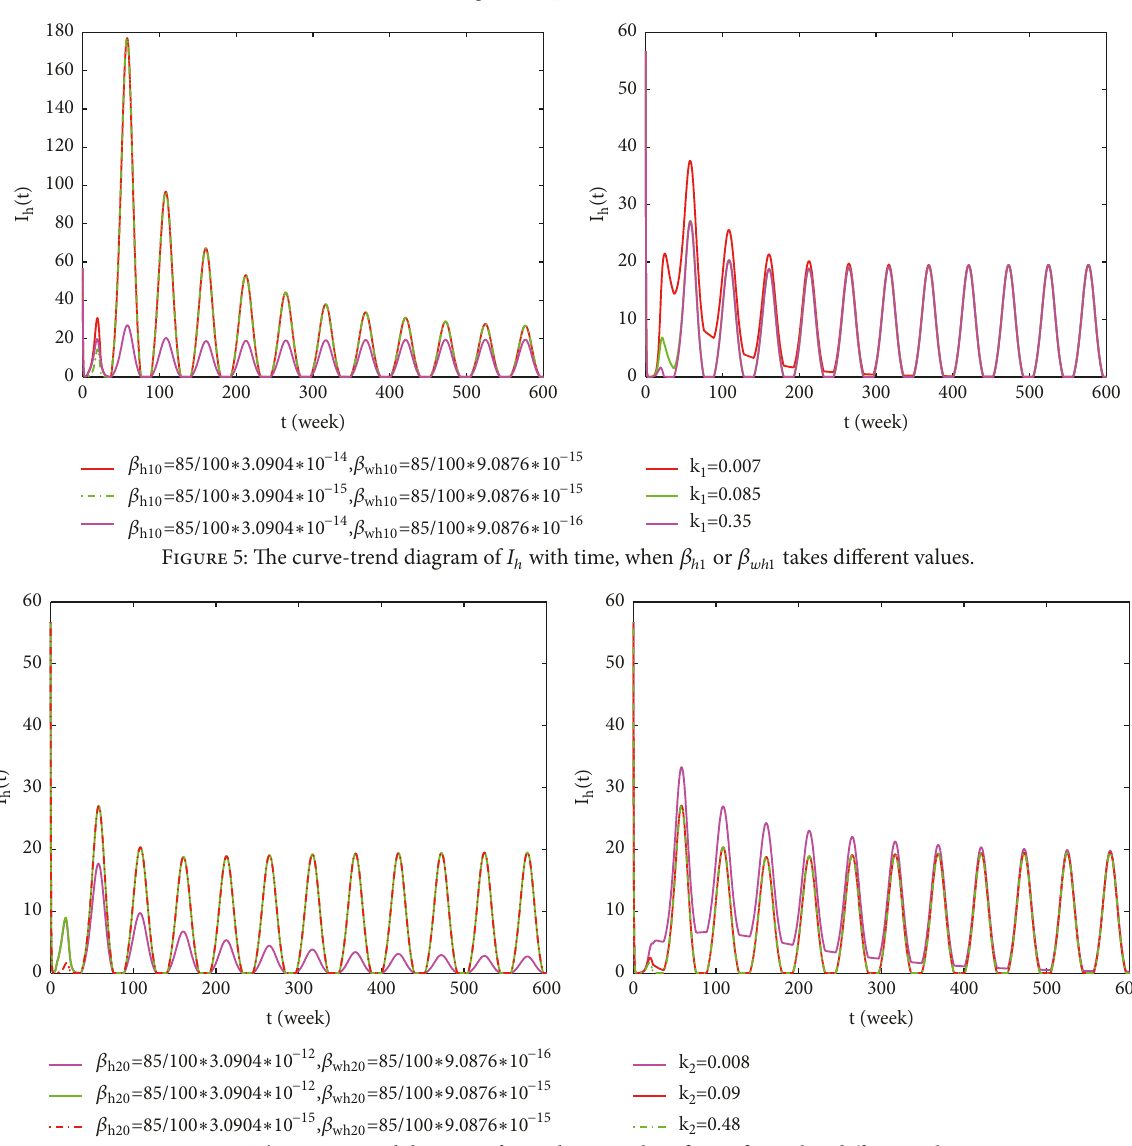
Figure 6: The curve-trend diagram of 𝐼 ℎ with time, when 𝛽 ℎ2 or 𝛽 𝑤ℎ2 takes different